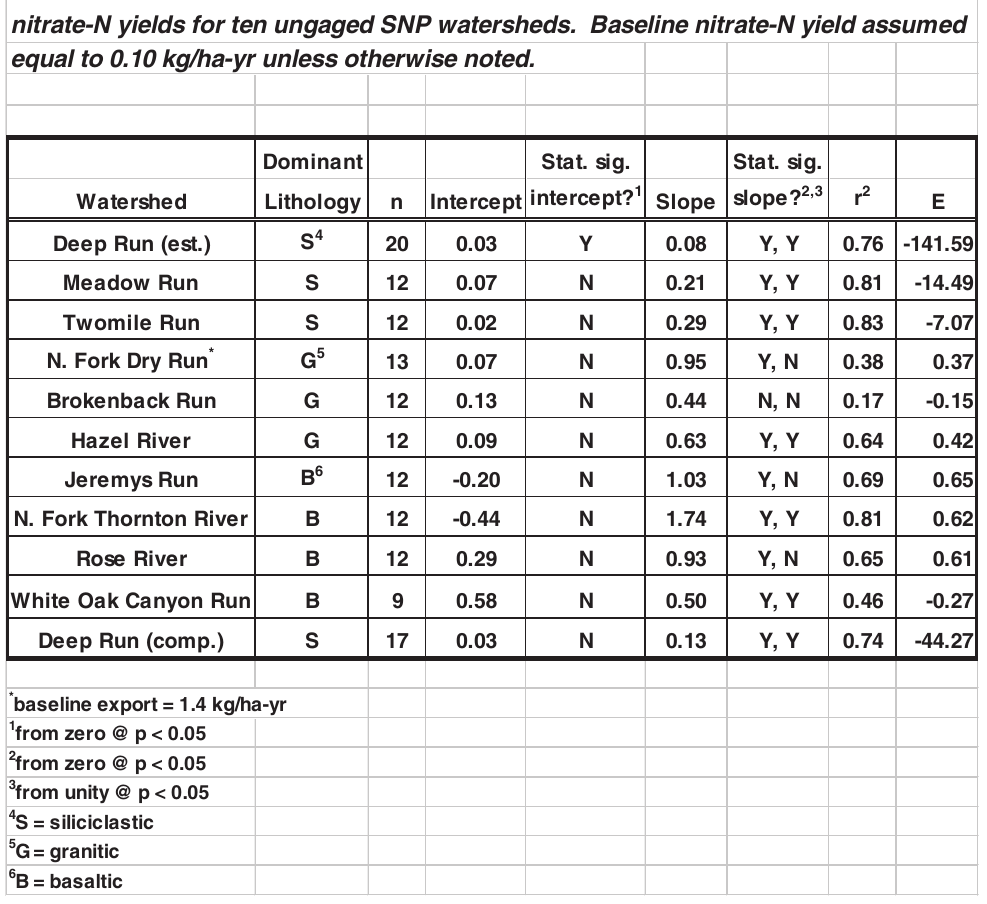
Table 1. Statistical comparison of UNERF model predictions and estimated annual nitrate-N yields for ten ungaged SNP watersheds. Baseline nitrate-N yield assumed equal to 0.10 kg/ha-yr unless otherwise